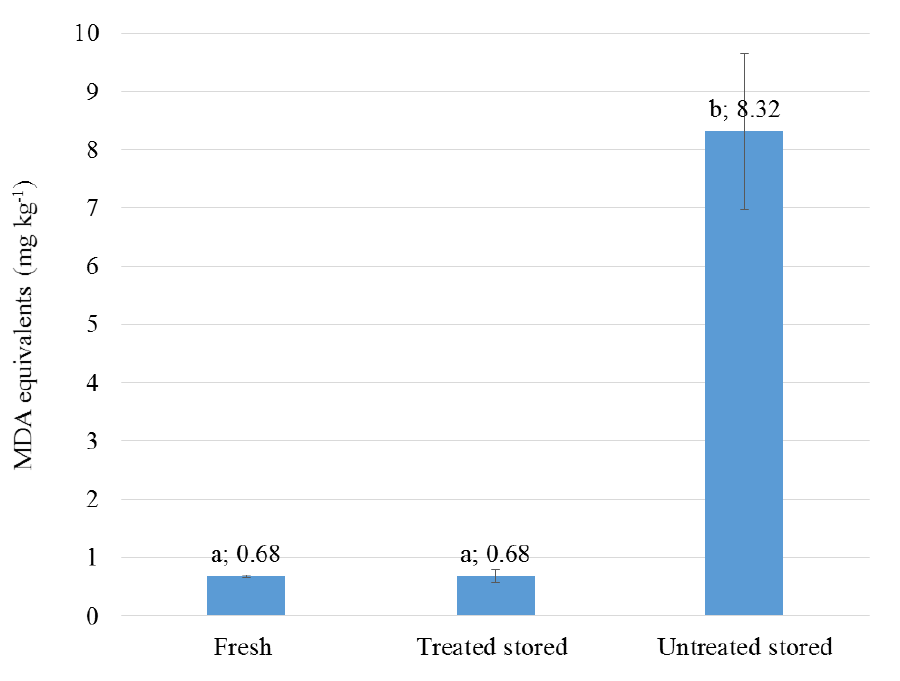
Figure 1. The effect of treatment with thymol on the oxidative stability of the sausage samples. Stored samples were refrigerated at 6 °C for eight weeks. Significant differences ( p < 0.05) between the mean values ( n = 6) are indicated by different letters at the top of the columns.